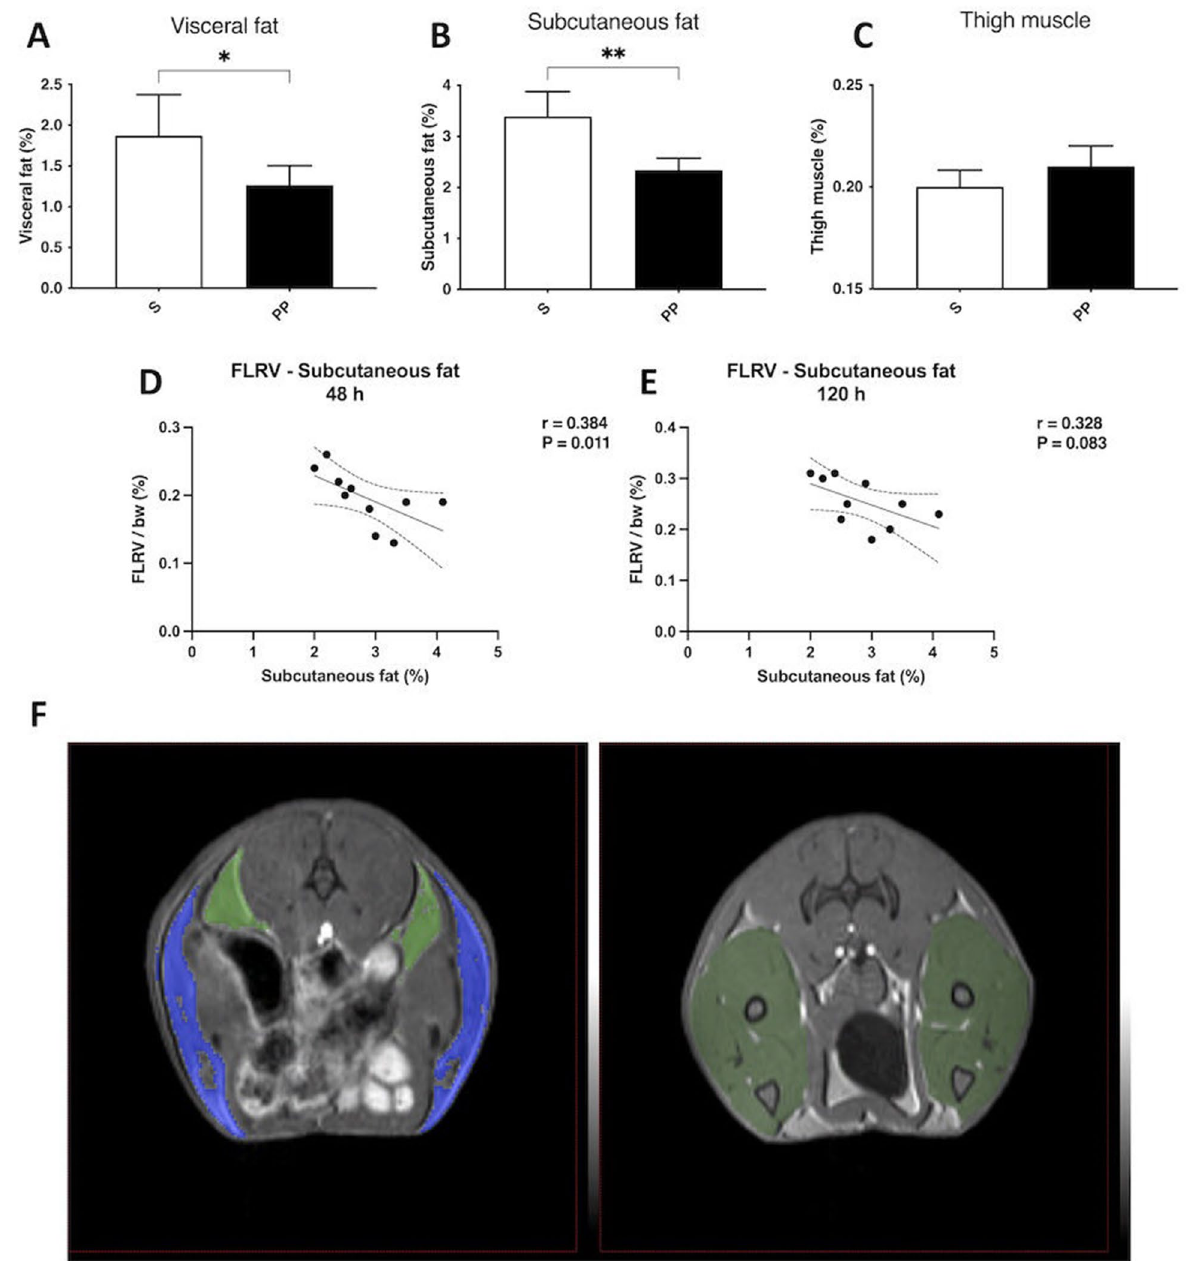
Figure 5. Preoperative magnetic resonance imaging (MRI)-volumetry of body composition and correlation between subcutaneous fat and future liver remnant volume (FLRV). Changes in visceral fat ( A ), subcutaneous fat ( B ) and thigh muscle ( C ) preoperatively. Linear regression analysis of correlation between subcutaneous fat and FLRV at 48 h ( D ) and 120 h ( E ) after associating liver partition and portal vein ligation for staged hepatectomy (ALPPS). Representative figure of preoperative MRI-volumetry ( F ) of the subcutaneous fat (blue), visceral fat (light green) and thigh muscle (dark green) in the PP group. * p < 0.050, ** p < 0.0010 physical prehabilitation (PP) versus sedentary